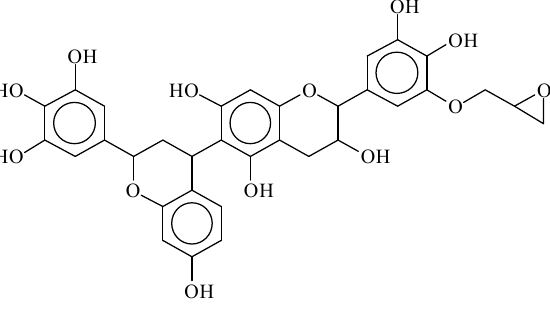
Scheme 5. Robinetinidin-gallocatechin dimer with one epoxy group equally representing the 654 Da MALDI peak. MALDI peak. MALDI peak. MALDI peak.